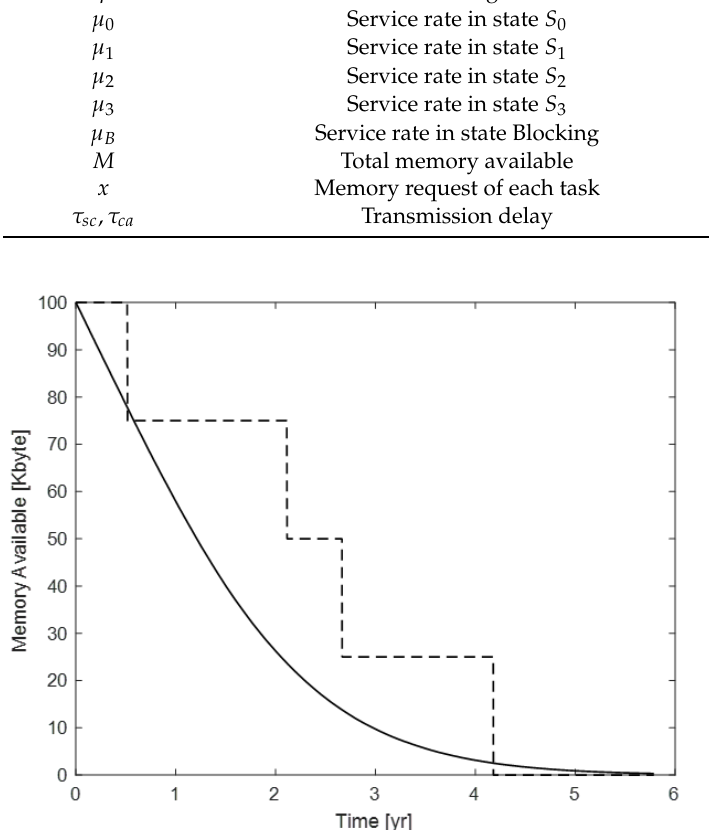
Figure 5. Decreasing available memory M ( t ) (continuous